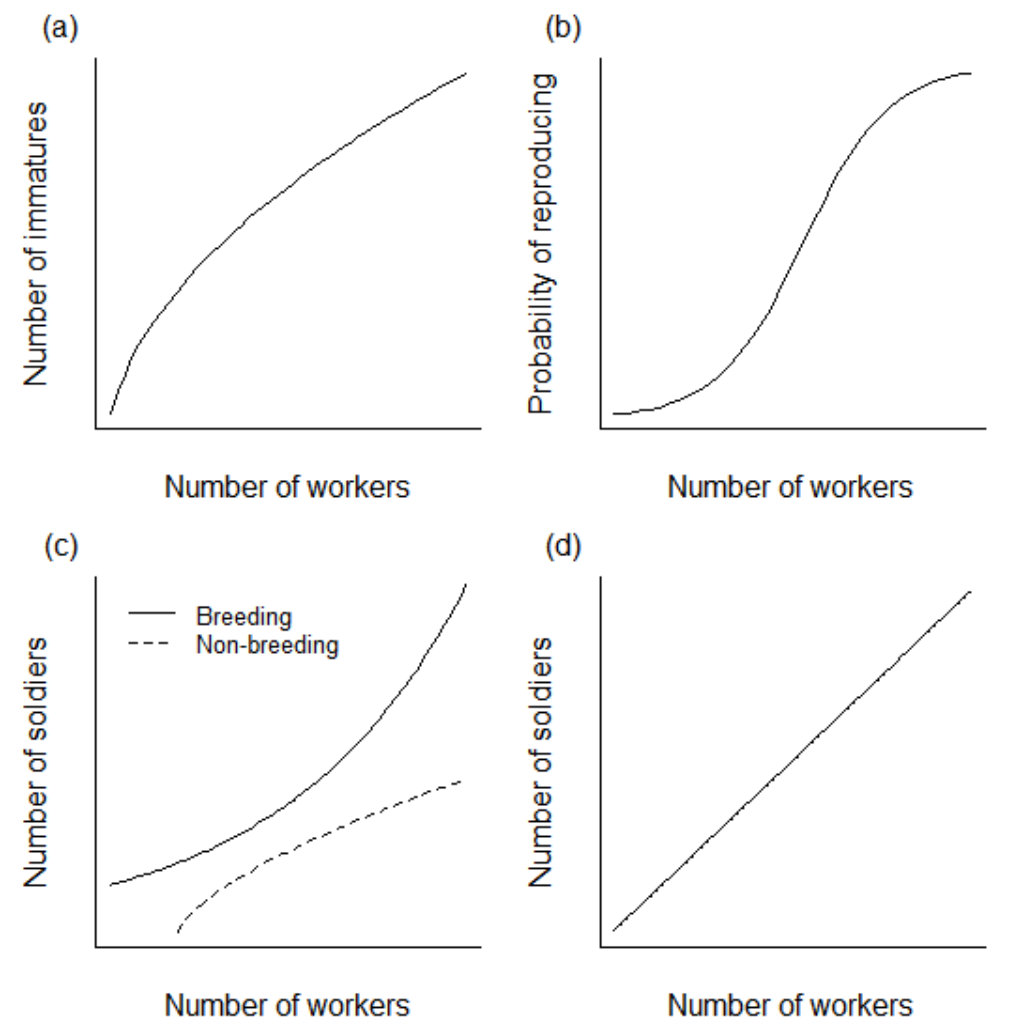
Fig 1 . Theoretical scaling relationships of growth, reproduction and defense in colonies of eusocial insects. (a) If colony growth rate declines as colonies grow, the number of immatures should be a decelerating function of the number of workers. (b) If colony reproduction requires a minimum workforce, the probability of reproducing should be a sigmoid function of worker number. (c) Optimal caste ratio theory (Oster & Wilson 1978) predicts that the number of soldiers should be higher in breeding than in non-breeding colonies, and that the relationship between soldier and worker number should be a concave-up curve in the former and a concave-down curve in the latter. (d) Termite caste allocation theory (Higashi et al. 2000) predicts that soldier number should be proportional to worker number, assuming that workers are exposed to extrinsic mortality outside the